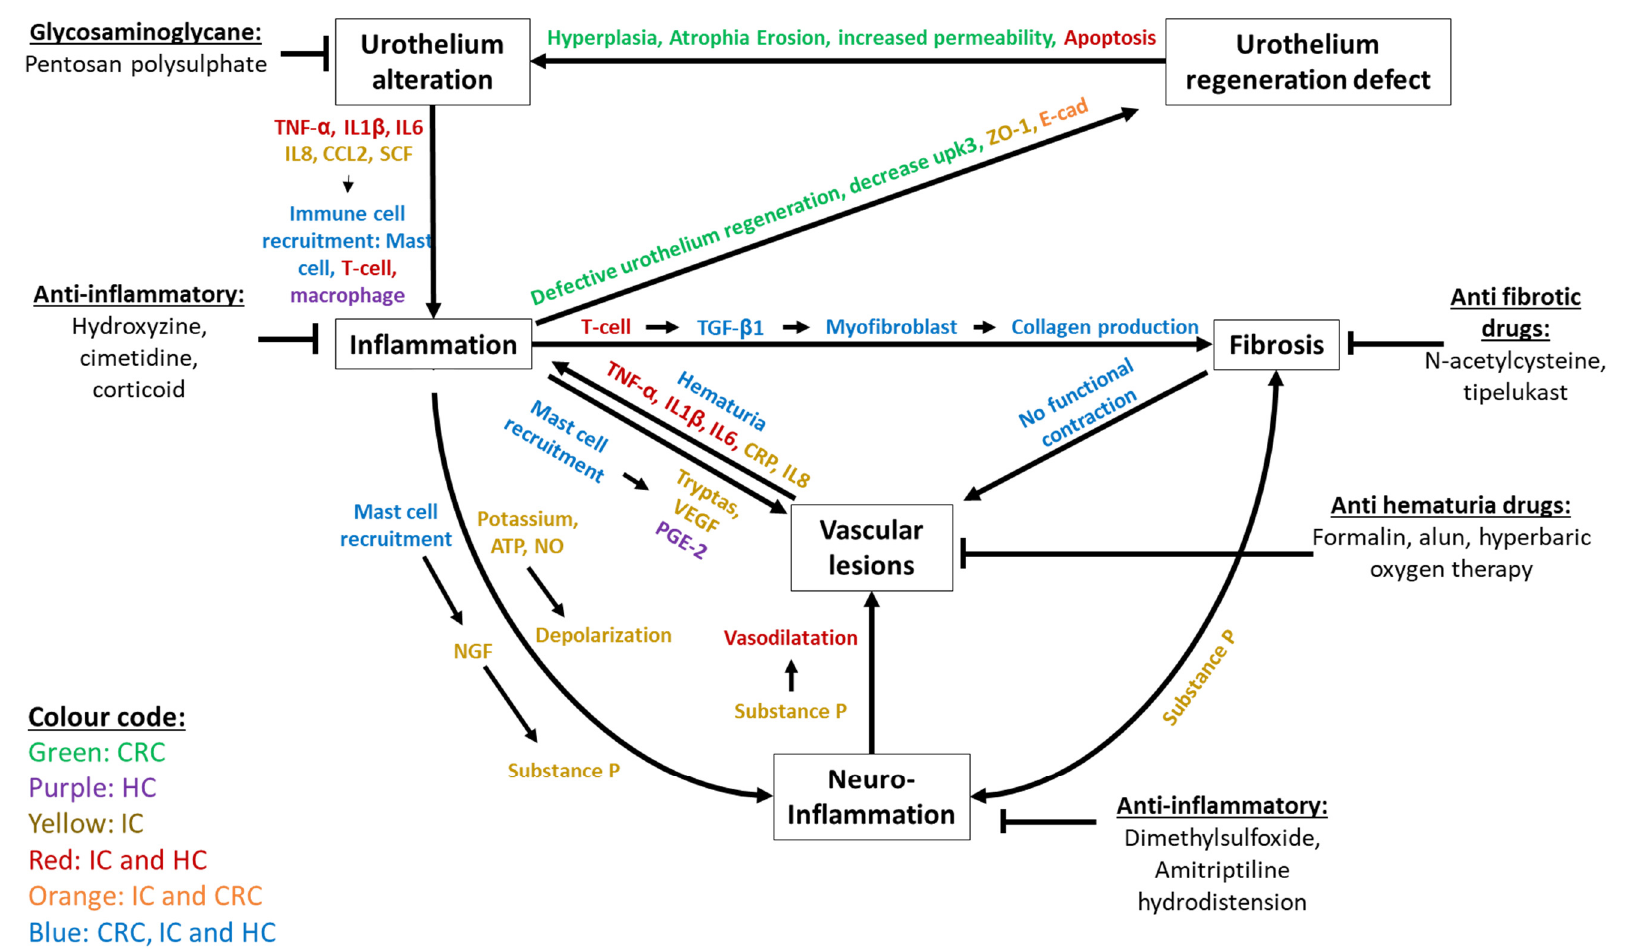
Figure 5. Synthetic description of the key processes and mechanisms shared by Interstitial, Hemorrhagic and Chronic Radiation Cystitis, including effectors and treatments. Color code: Green is used for effectors in CRC only, purple for those in HC only and yellow for those in IC only. Effectors found in IC and HC are shown in red and the effectors found in IC and CRC are shown in orange. The effectors common to CRC, IC and HC are shown in blue .